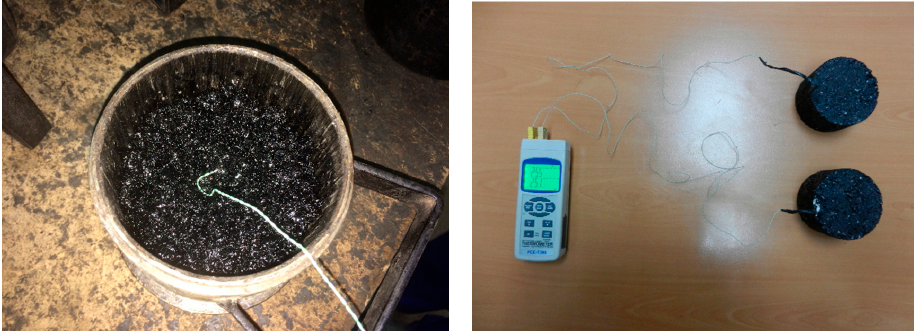
Figure 1. Thermo-sensor inside the specimens.